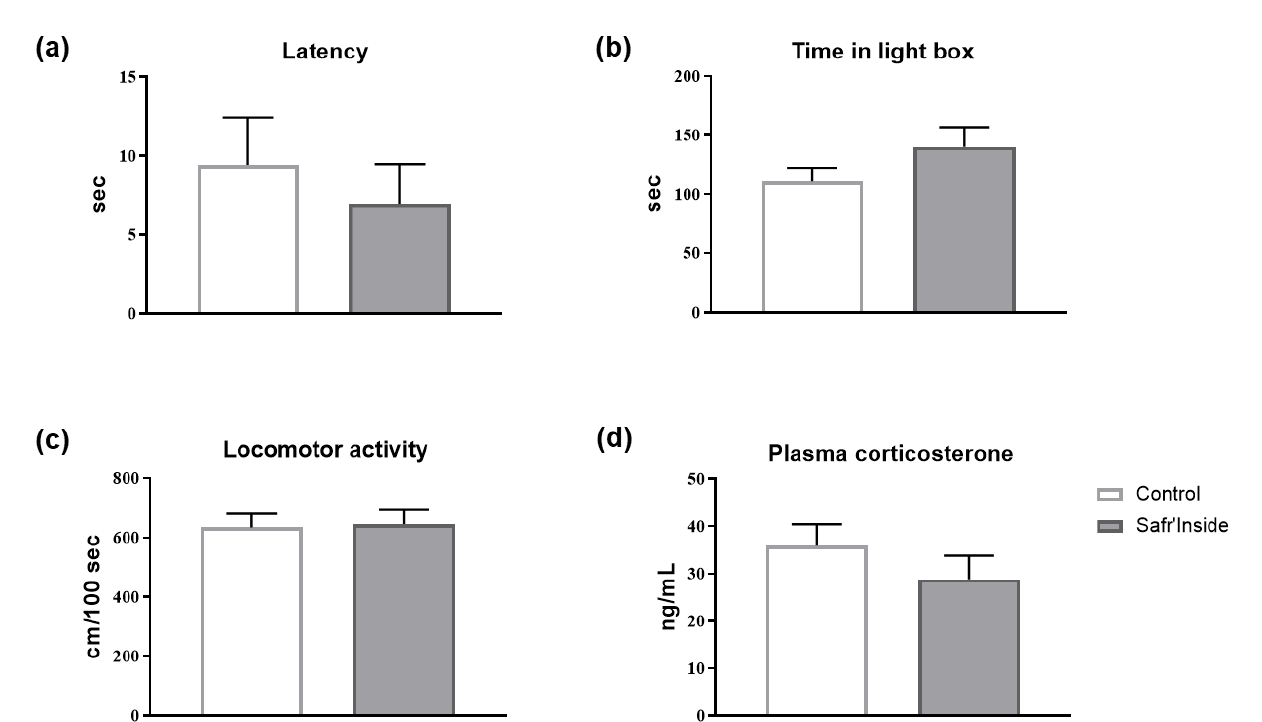
Figure 5. Effect of chronic oral administration of Safr’Inside TM (6.25 mg/Kg) on anxiety-like behavior, measured in the LDT, and plasmatic corticosterone levels. ( a ) Latency to enter in the light box of the LDT; ( b ) Time in light box; ( c ) Locomotor activity as assessed by the distance covered (cm) normalized for the time spent in the light box; ( d ) Plasma corticosterone levels in ng/mL. LDT has been conducted after 3 weeks of treatment and 3 h after the gavage. Results are shown as mean ± SEM. Control (Water): n = 8; Safr’Inside: n = 9.